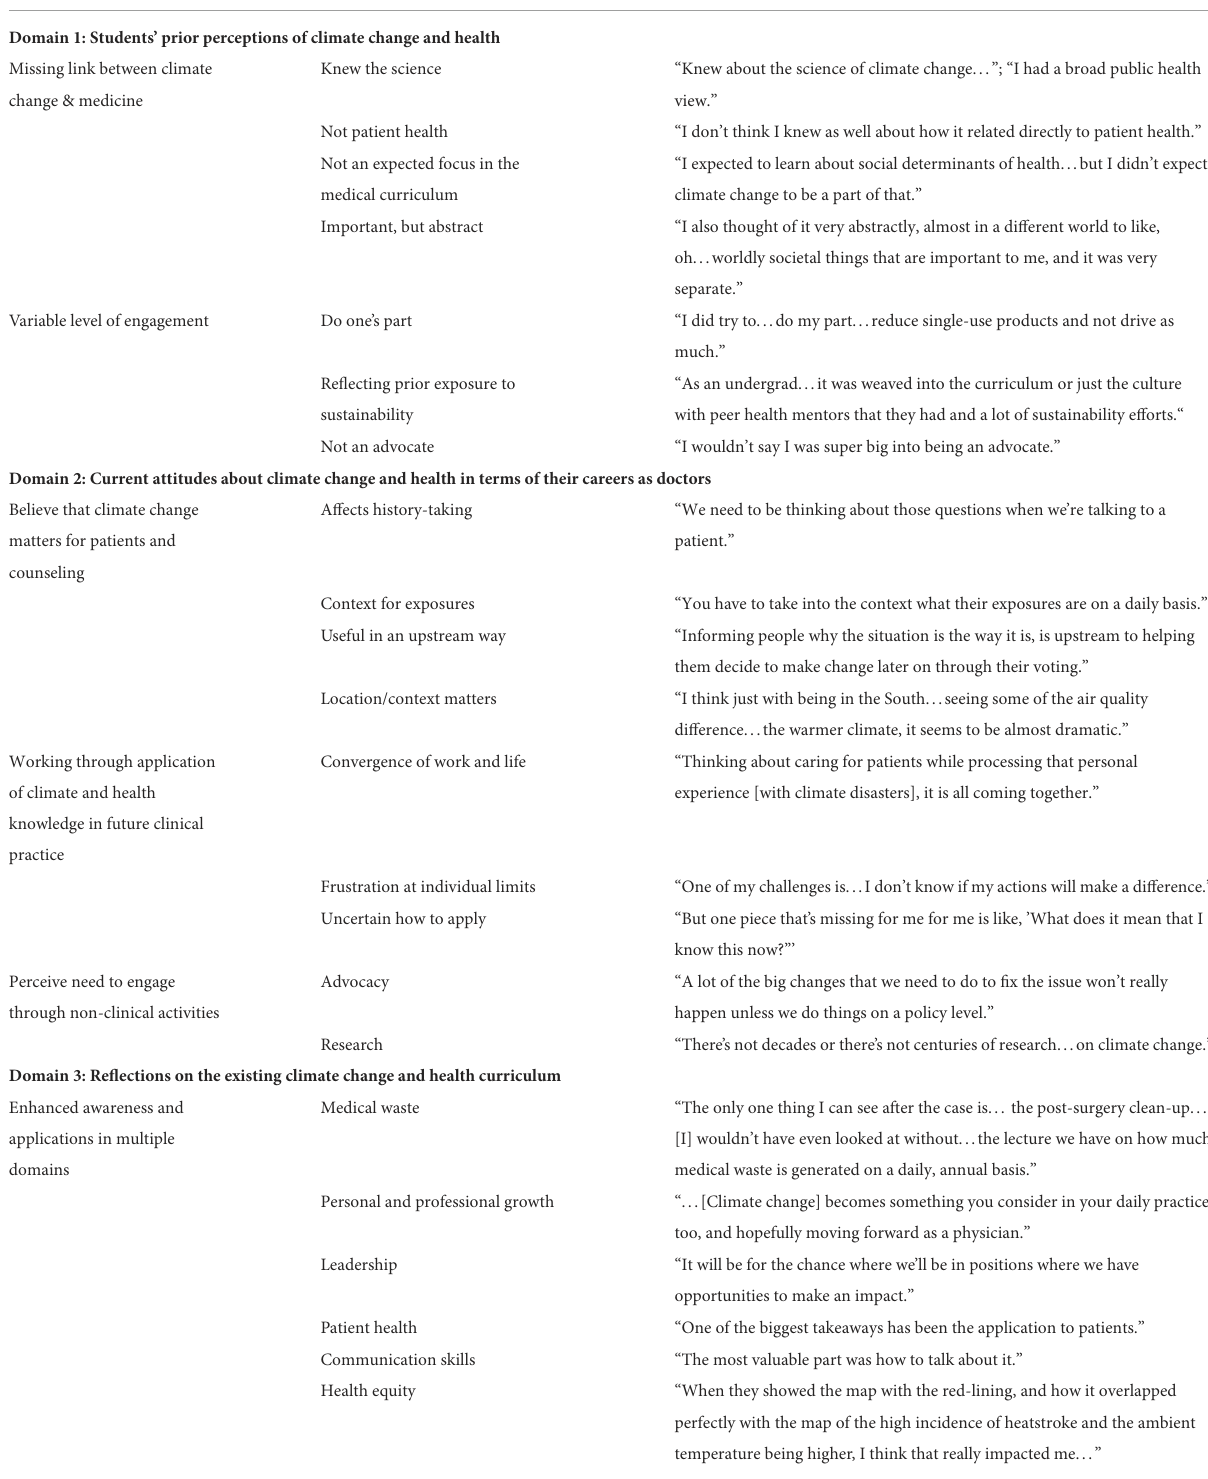
TABLE 1 Student focus group evaluation: Perceptions of climate change and a co-created and disseminated pre-clinical climate change and health curriculum across four